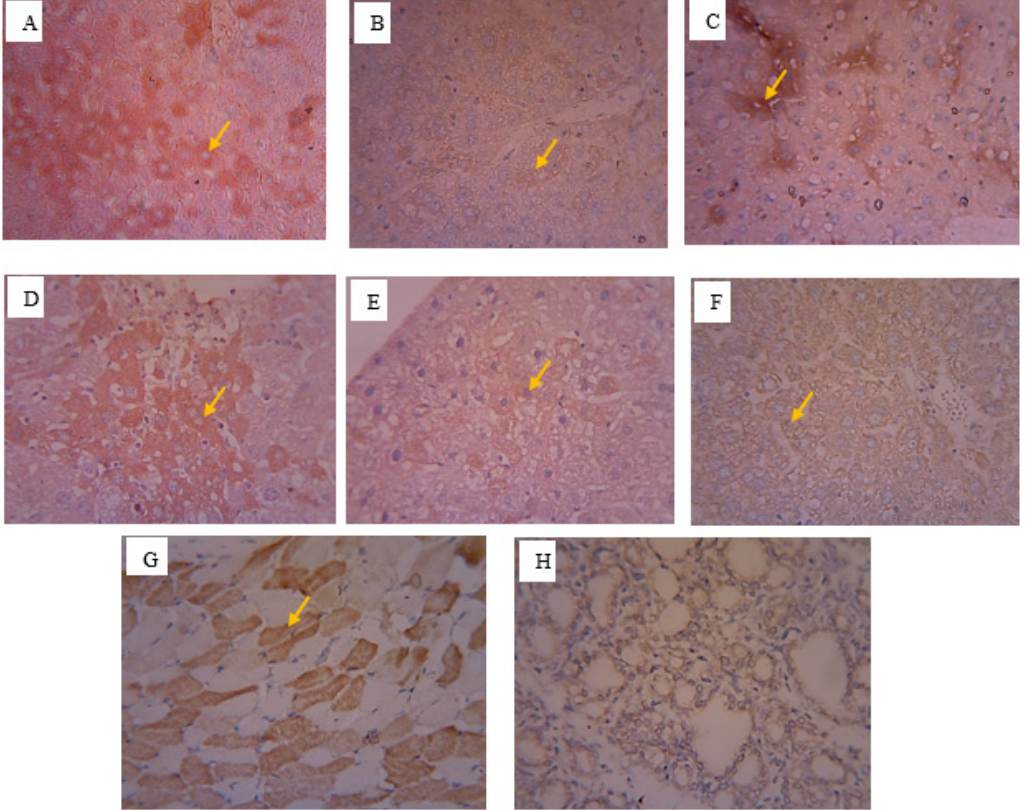
Figure 3. Visualization of the immunohistochemistry results in the liver of the protein expression of SREBP-2 groups: ( A ) normal, ( B ) Obes0, ( C ) Obes2, ( D ) Obes7, (E) Obes14, ( F ) Obes21. Mice tonsil preparations were used as the positive control ( G ) and negative control ( H ). Arrows indicate SREBP-2 expression.